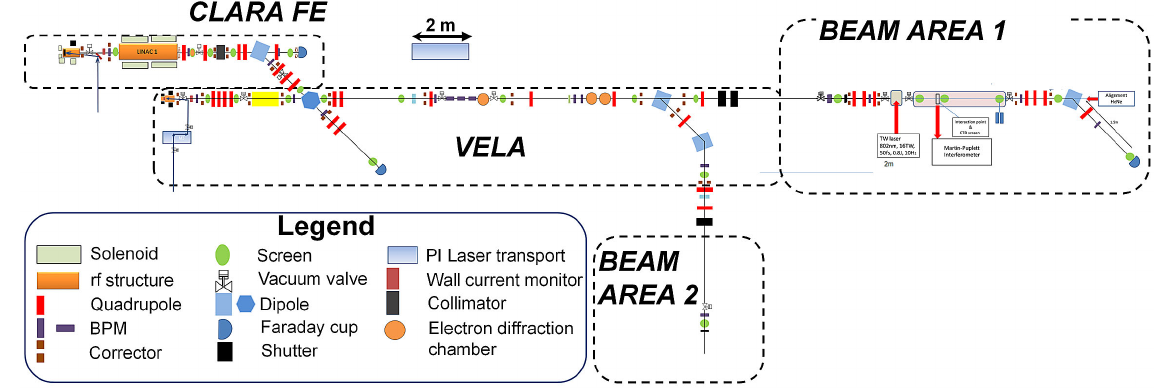
FIG. 2. Schematic of the CLARA FE and VELA. The S bend transports the beam with a momentum up to 50 MeV = c from the CLARA FE to be delivered to beam areas at the end of the VELA